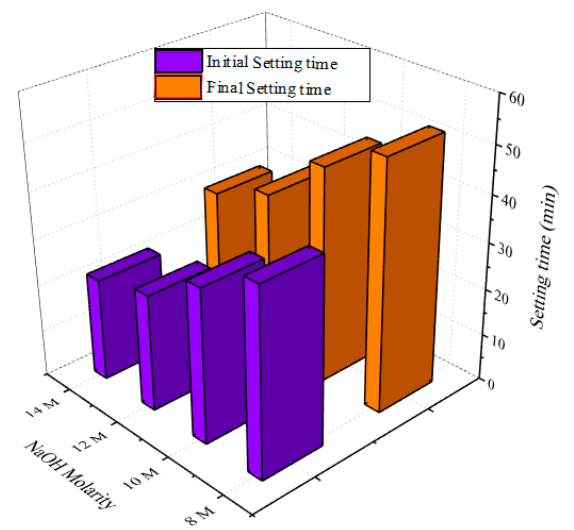
Figure 4. Setting time of FA-based geopolymer paste vs. NaOH molarity.